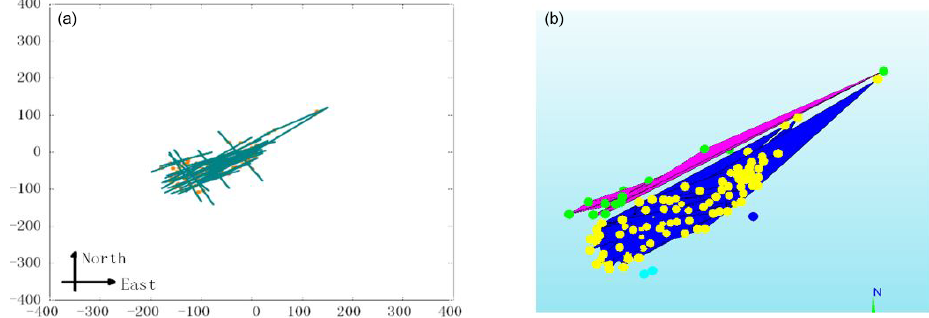
Figure 9. Three-dimensional view of cracks ( a : original fracture strike structure; b : three-dimensional view).